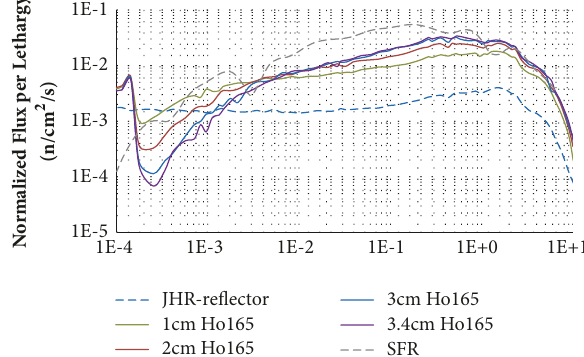
Figure 20: Effect of 165 Ho on the reference JHR spectrum for varying screen thickness.